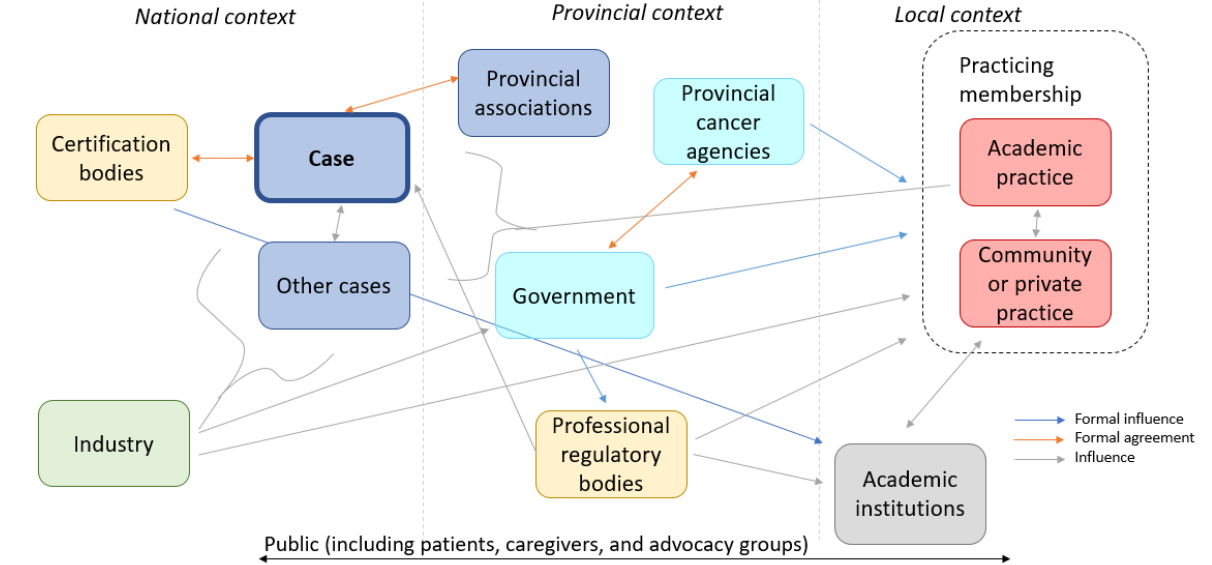
Figure 2. Artificial intelligence strategy integration in Canadian radiation therapy and medical imaging